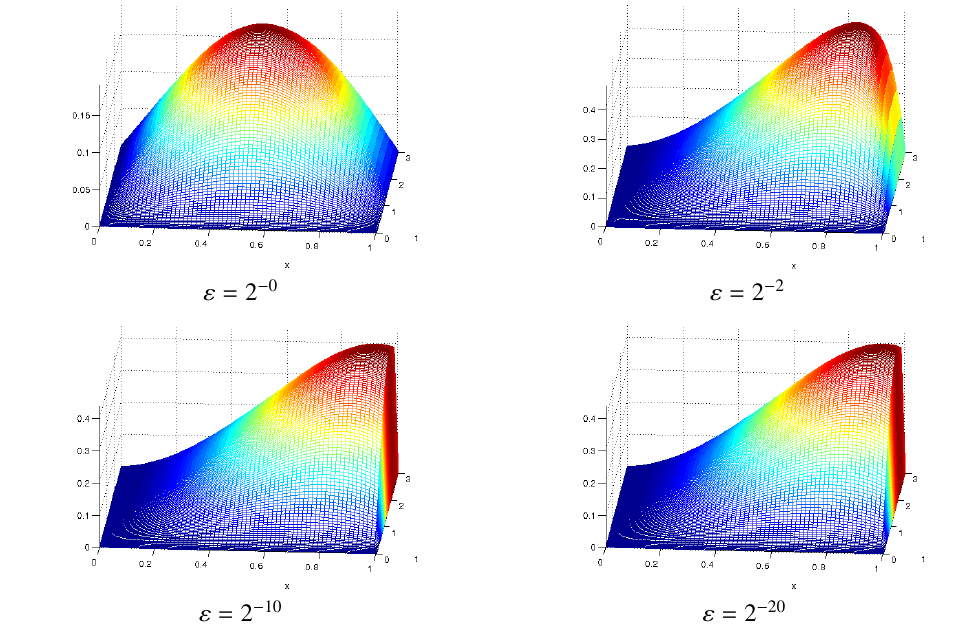
Figure 1. 3D view of numerical solution of Example 4.1 with boundary layer formation as ε → 0.